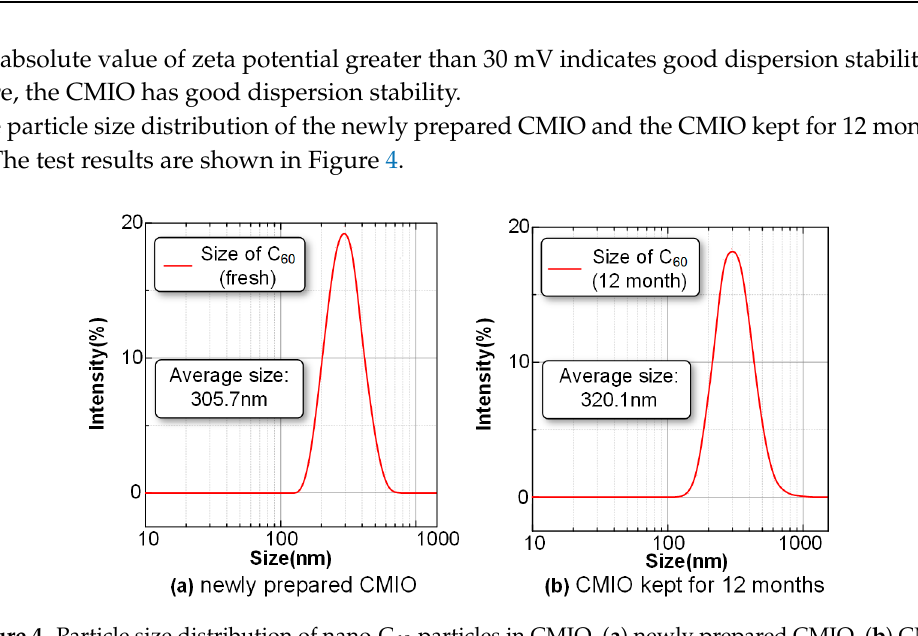
Table 3. Zeta potential of nano-C 60 modified insulating oil (CMIO) (100 mg / L, pH = 7).